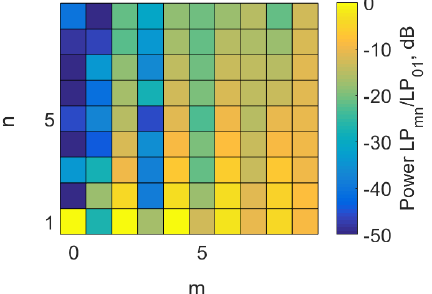
Figure 11. Calculated coupling suppression of spurious modes by the main mode coupler.